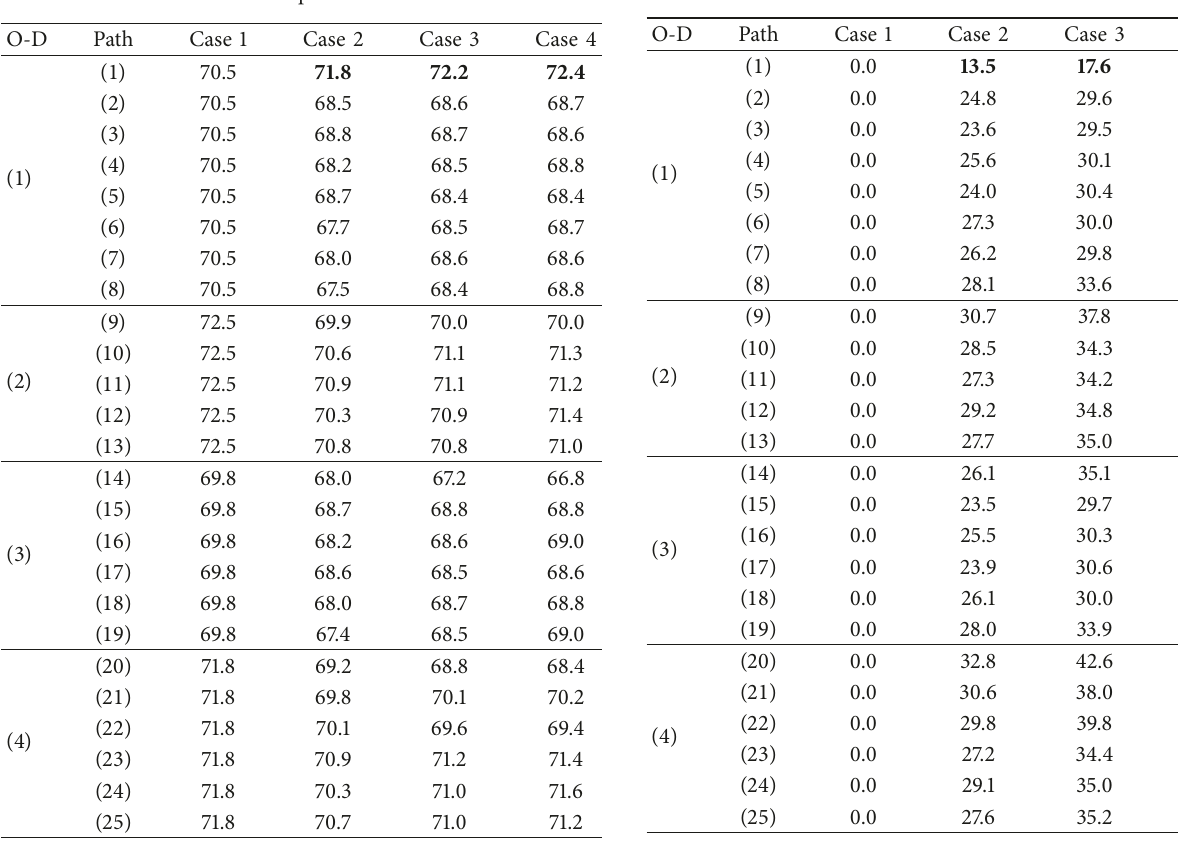
Table 6: Mean path travel time. Table 7: Path travel time